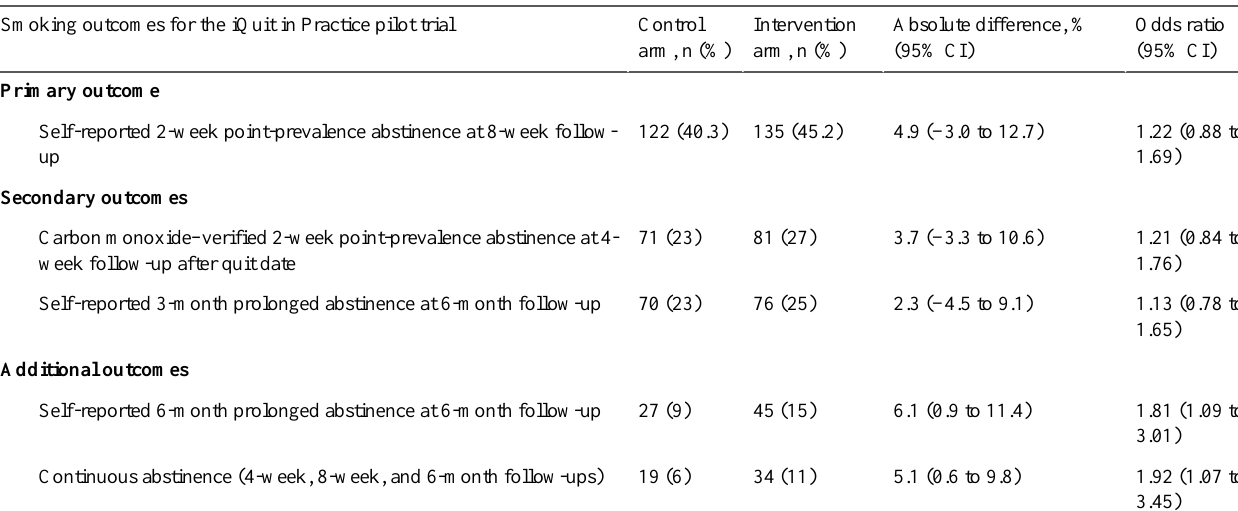
Table 2. Summary of smoking outcomes from the iQuit in Practice pilot